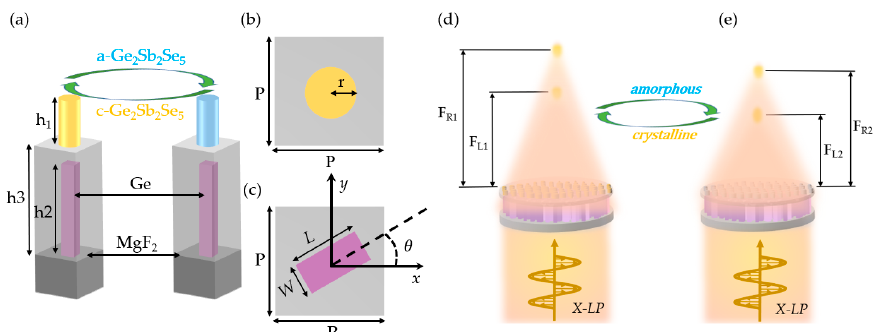
Figure 1. ( a ) The schematic diagram of the unit structure of the bilayer metalens. ( b ) Upper view of the GSSe unit nanopillar. ( c ) Upper view of the Ge rectangle unit nanopillar. The long and short axis of the Ge rectangle are L and W , and θ is the angle between the long axis and the horizontal direction. Artistic rendering of a bifocal varifocal metalens under X-LP wave excitations when GSSe is in the crystalline state ( d ) and the amorphous state ( e ).